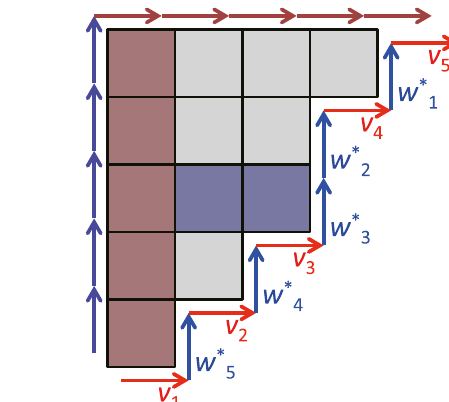
no extra signs appear, [ v 5 (cid:1) (cid:1) (cid:1) v 1 ; w (cid:3) 5 v 4 w (cid:3) w (cid:3) v 3 w (cid:3) v 2 v 1 w (cid:3) , [ v 5 (cid:1) (cid:1) (cid:1) v 1 ; w (cid:3) 1 2 3 4 5